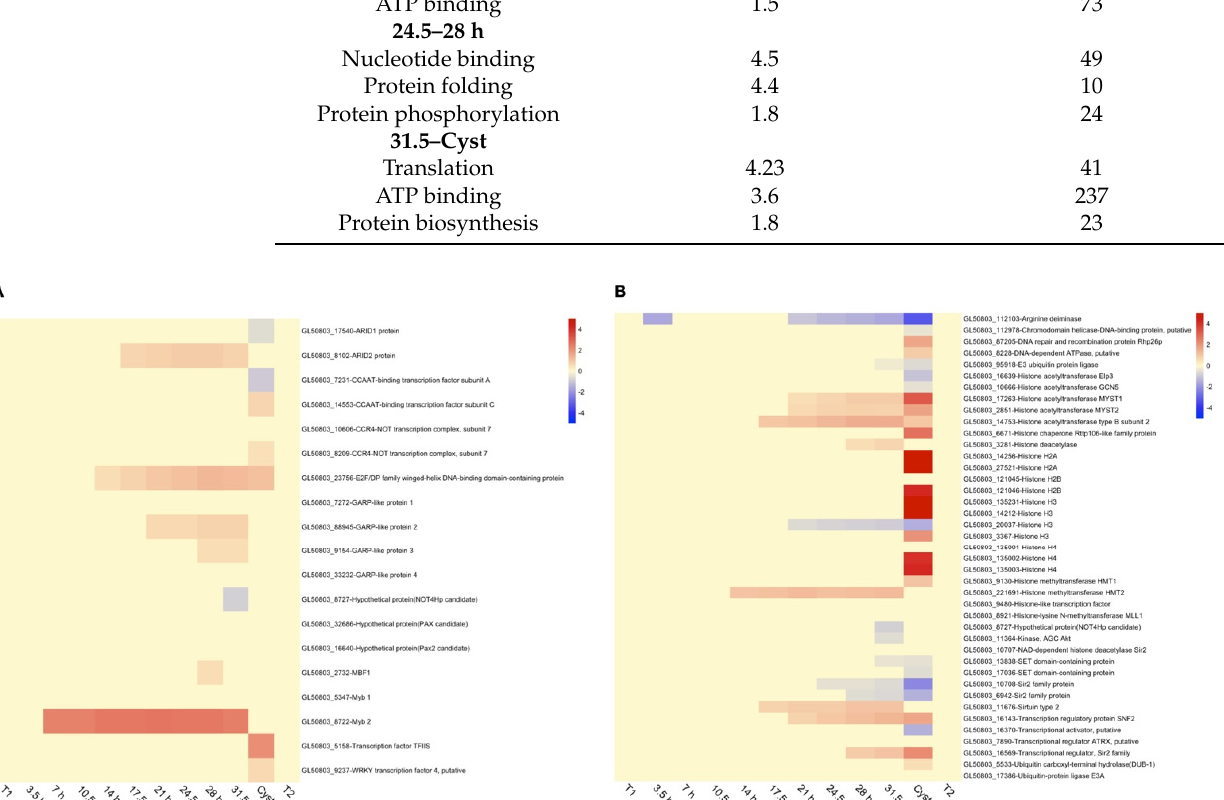
Figure 2. Heat-map showing expression changes through-out encystation of ( A ) transcription factors and ( B ) chromatin modifiers. All changes are in log2 space and capped at − 5 and 5, respectively, to improve visualization. Up-regulation is shown in red, while down-regulation is shown in blue. For each gene, the unique Geneid (starting in GL50803_) and the annotated function is given.